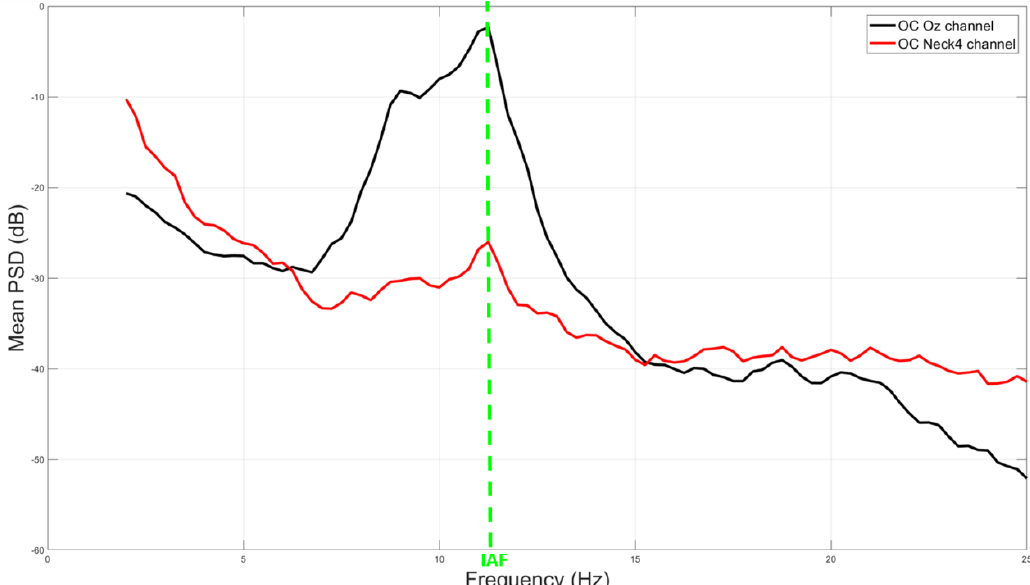
Figure 4. Representative example of averaged power spectra amplitude difference between EEG (black line) and noEEG (red line) channels. The green arrows highlight the consistence of the Alpha peaks (i.e., IAF value) of the brain (Oz channel) and body (Neck4 channel) spectra in the mean OC condition.